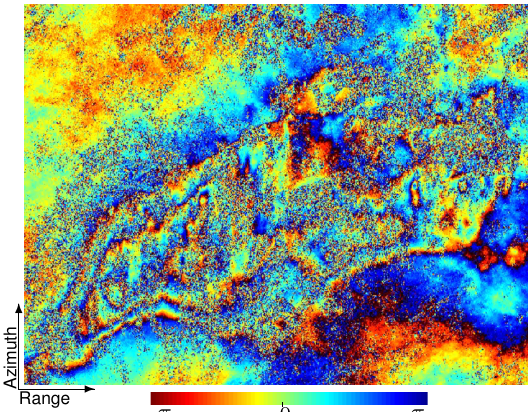
Figure 5. A five-months interferogram over Tehran basin, between February 2017 and July 2017. There are almost three fringes in the deformation area, equivalent to 8.4 cm LOS deformation in five months Results from the Proposed Method We selected few coherent interferograms with short baselines as visualized as red lines in figure. 6. The a-priori deformation field obtained from these interferograms is shown in figure 7 A. The gradient phases calculated from the a-priori deformations are used as the center of the cost functions of the SNAPHU algorithm in STAMPS software.